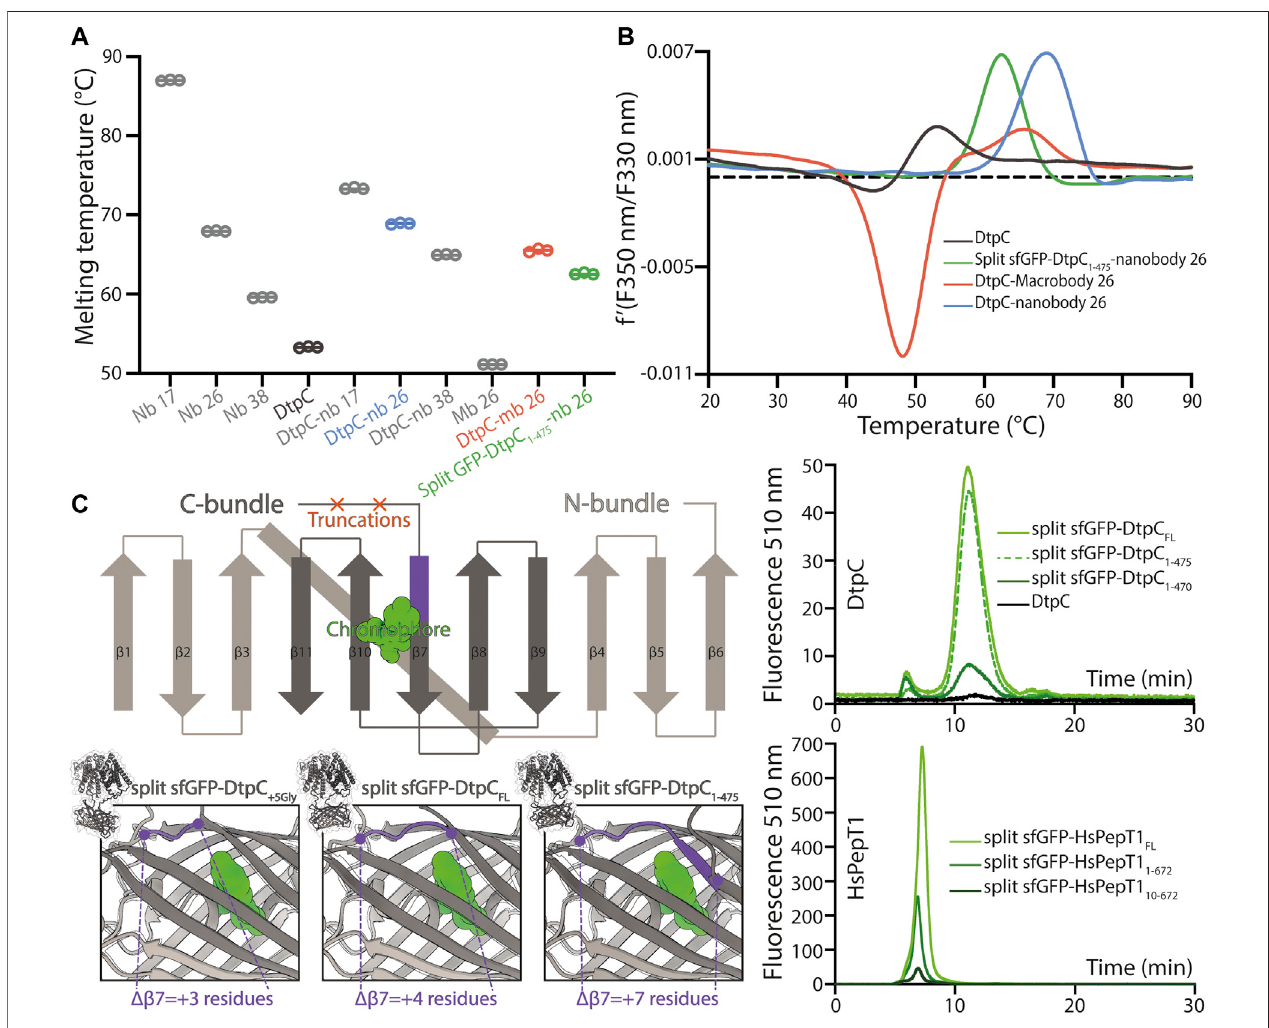
FIGURE 2 | Characterization of the different fi ducial markers. (A) The melting temperature of each fi ducial and DtpC- fi ducial complex was measured by nano- differential scanning fl uorimetry (DSF) in triplicate measurements as shown as open circles. The average of the three values is marked by a line. (B) The fi rst derivative of thesummarizeddatain (A) isshownforDtpCandthethreeimagedsamplestogetherwiththerespective fi ducial. (C) AschematicrepresentationofthesplitsfGFP-DtpC architecture is shown on the top left panel. Below, structure predictions were generated for split-sfGFP-DtpC +5Gly , split-sfGFP-DtpC FL , sfGFP-DtpC 1-475 , and overlaid with sfGFP (PDB accession number 2B3P). The dark-violet coloring corresponds to the fraction of ß7 which is properly folded in sfGFP while unfolded in the restrained chimeric construct. The right panel shows HPLC chromatogram pro fi les monitoring the fl uorescence of the chromophore of split sfGFP in the context of the indicated constructs, using 480 nm as excitation wavelength and recording at 510 nm the emitted